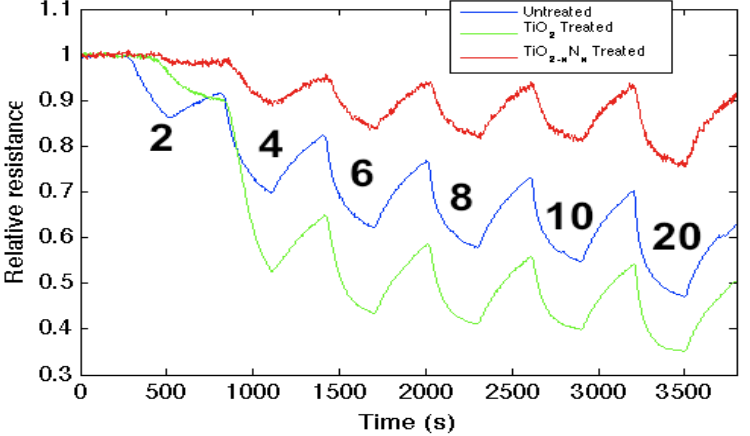
Figure 3. Response corresponding to decreasing resistance as NH an untreated porous silicon (PS)-, TiO TiO N -treated interface is basic relative to the PS- and TiO 2 − x x